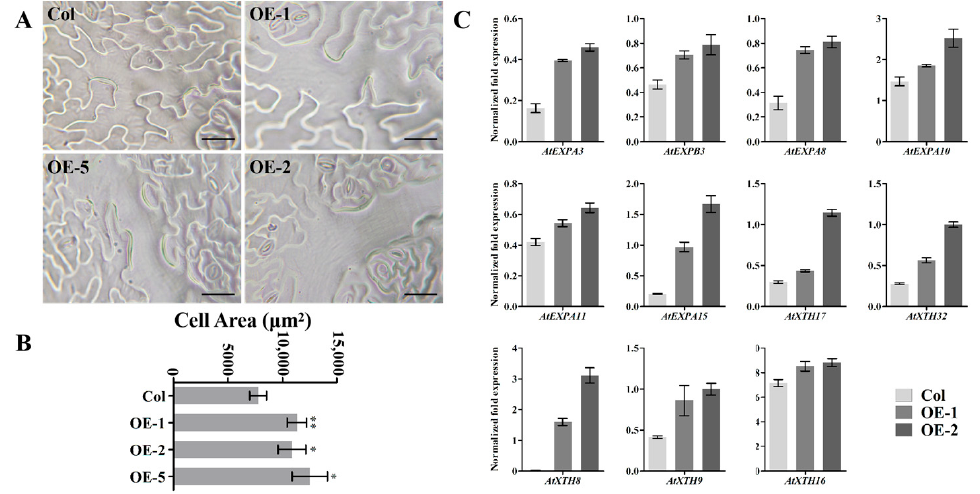
Figure 6. Ectopic expression of EjNACL47 enlarges cell area in Arabidopsis . ( A ) Changes in lower